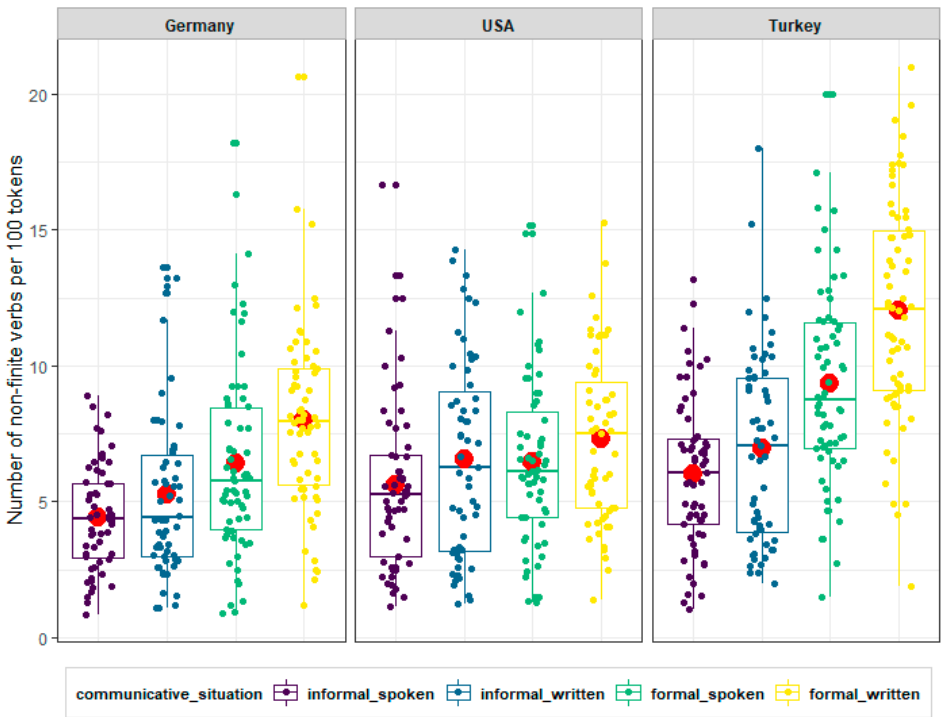
Figure 2. Box-plots that represent the distribution of non-finite verbs by speakers from the three countries with the focus on register and mode.